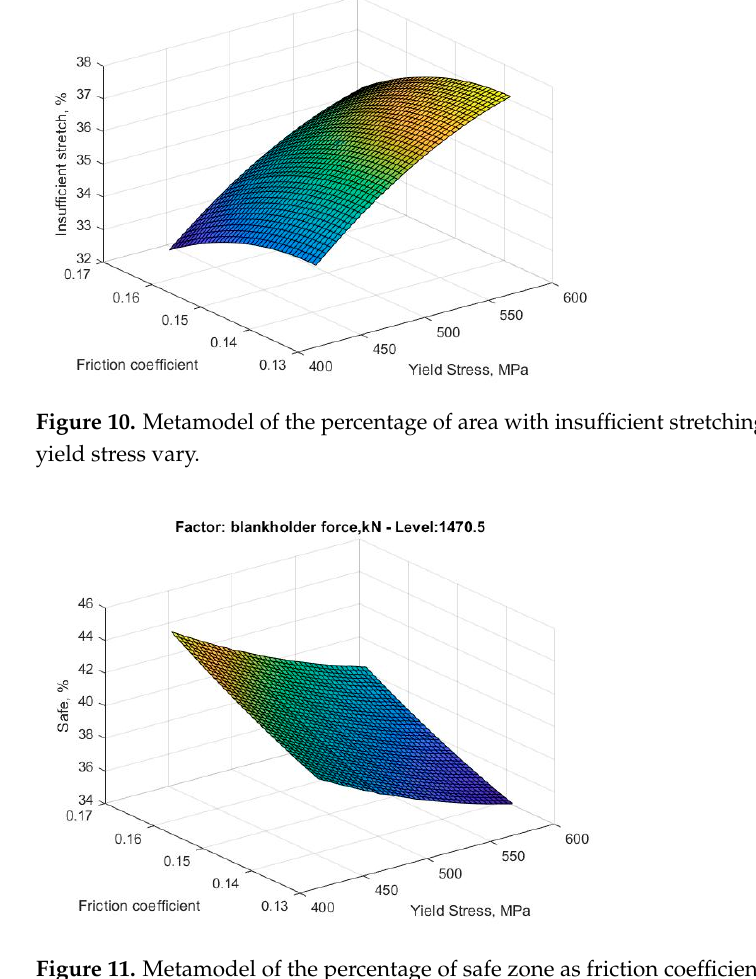
Figure 11. Metamodel of the percentage of safe zone as friction coefficient and yield stress vary.